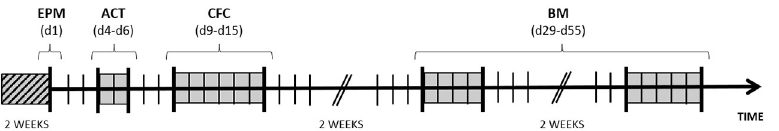
Fig 1. Experimental time-line and design. After two weeks of accommodation to the animal laboratory facilities, 69 males and 72 females belonging to the three genotypes (WT, cHZ, and cKO) were evaluated for anxiety-related behaviour (EPM, d1), spontaneous locomotor activity (ACT, from d4 to d6), and contextual fear conditioning memory (CFC, from d9 to d15). Following two weeks of recovery, the spatial memory was assessed (BM, from d29 to d55)